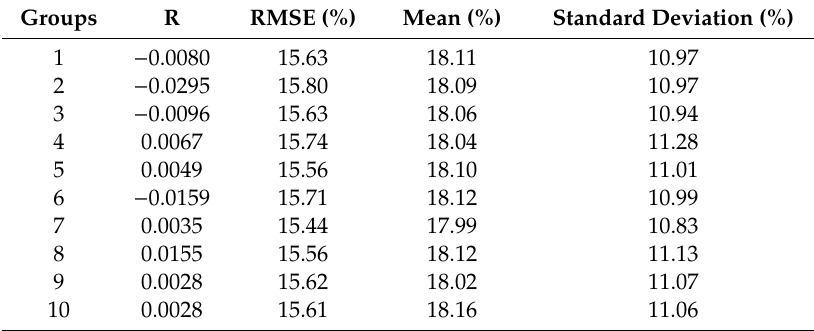
Table 6. Performance of the estimated MPF (the average of the observed MPF with 10 groups of random noises added) against the observed